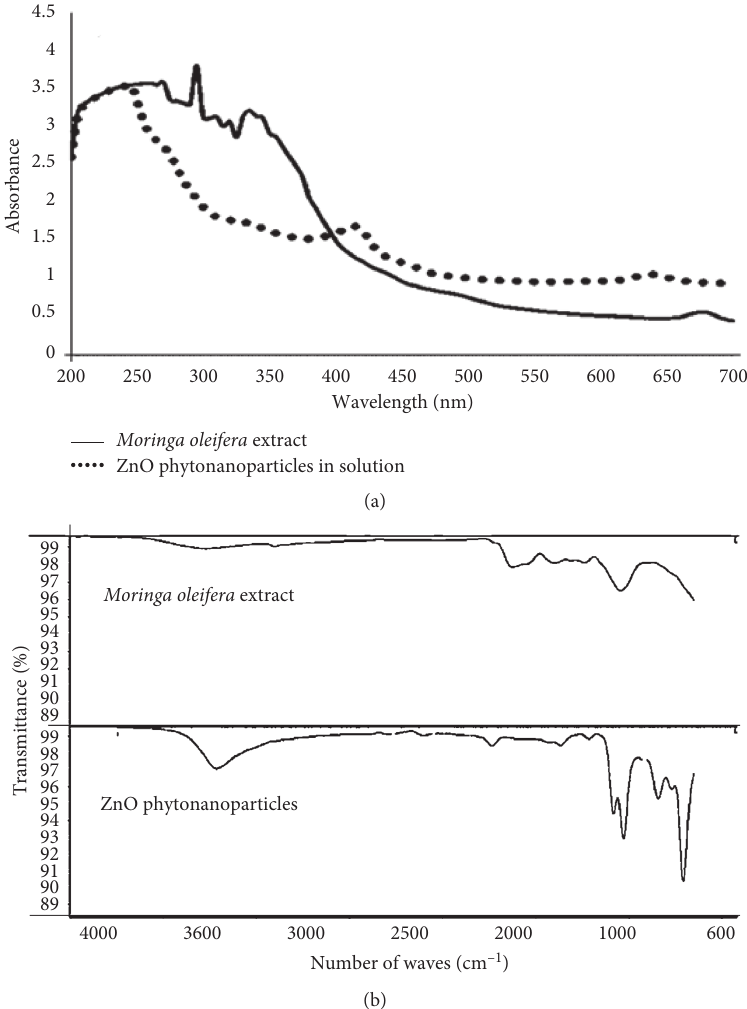
Figure 2: Characterization of ZnO phytonanoparticles with the aqueous extract of Moringa oleifera : (a) UV-Vis absorption spectrum and (b) FT-IR absorption